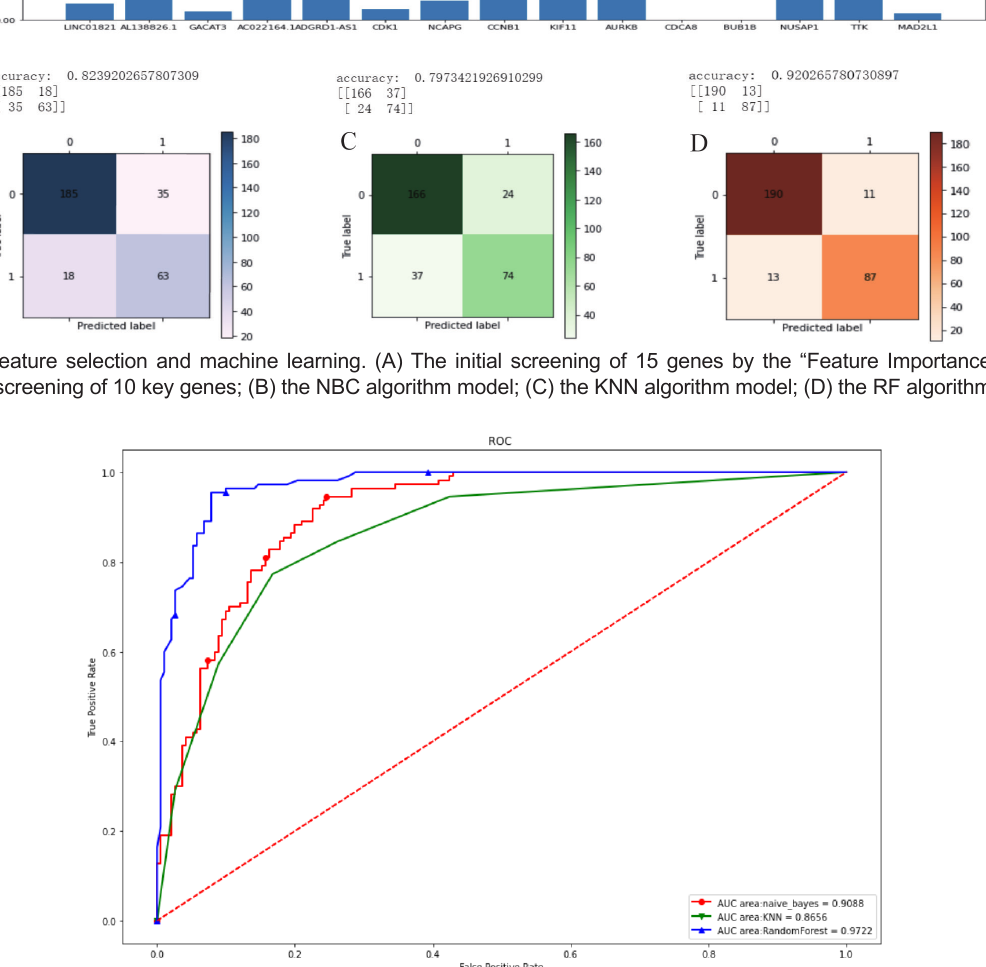
Figure 7. Internal test set ROC curves. Red dashed line is the reference line, red solid is the NBC algorithm model, green is the KNN algorithm model, and blue is the RF algorithm model